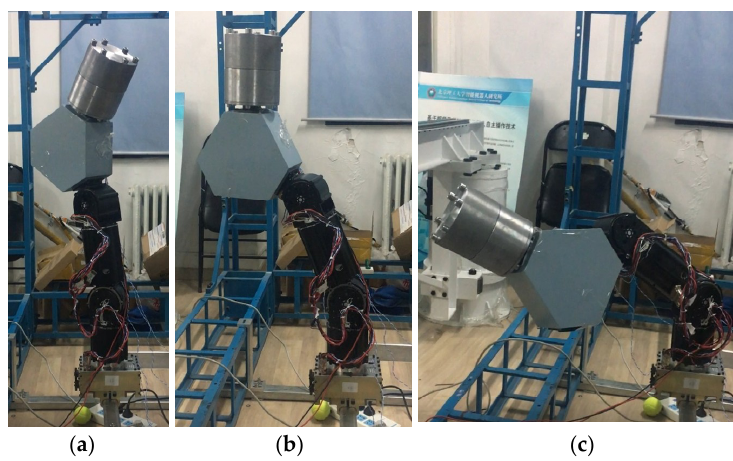
Figure 10. The motion of single arm under 20 kg load. ( a ) Motion start; ( b ) In the process of motion; ( c ) Motion complete.